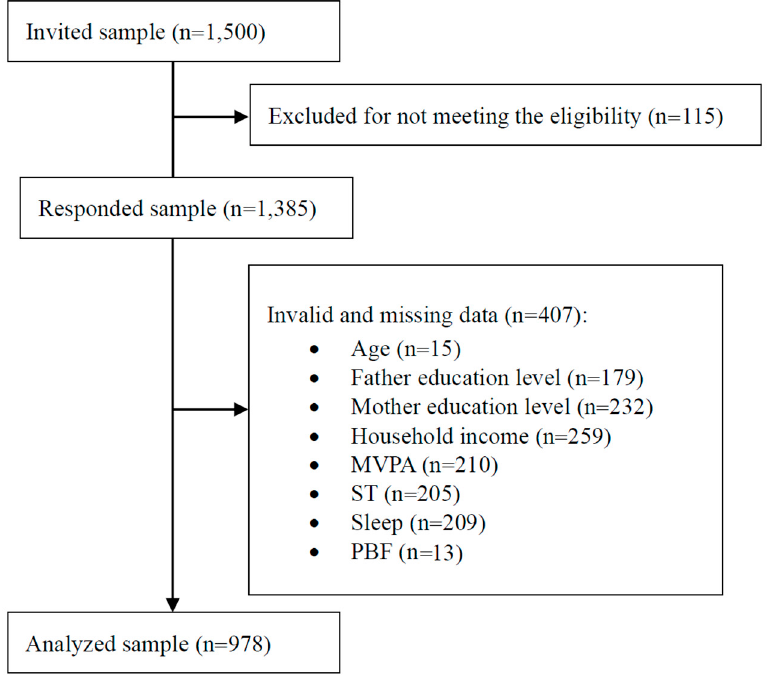
Figure 1. STROBE diagram of study process; MVPA = moderate and vigorous physical activity; ST = screen time; PBF = percent of body fat.